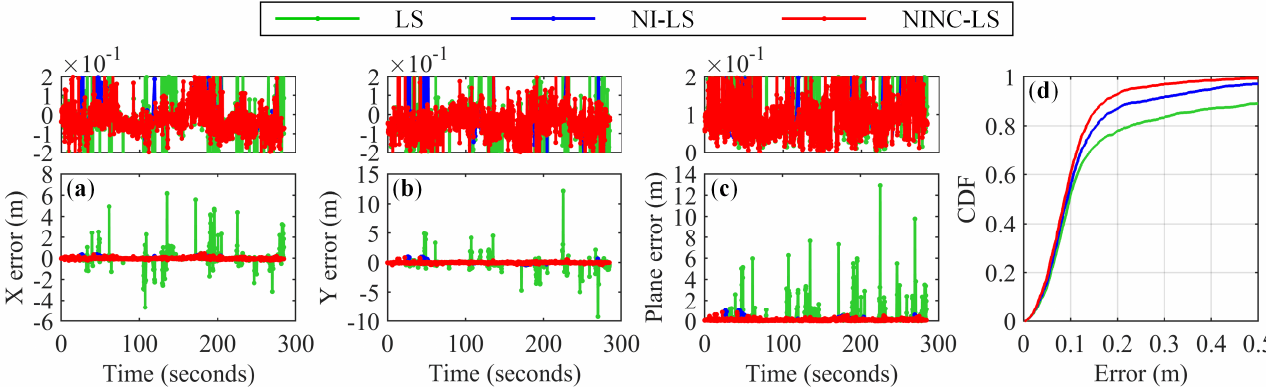
Figure 10. Positioning errors of the LS (green), NI-LS (blue) and NINC-LS (red) methods: ( a ) X direction, ( b ) Y direction, ( c ) plane direction, and ( d ) CDF of the positioning errors. Table 3. Accuracy evaluation of the LS, NI-LS, and NINC-LS methods. LS NI-LS